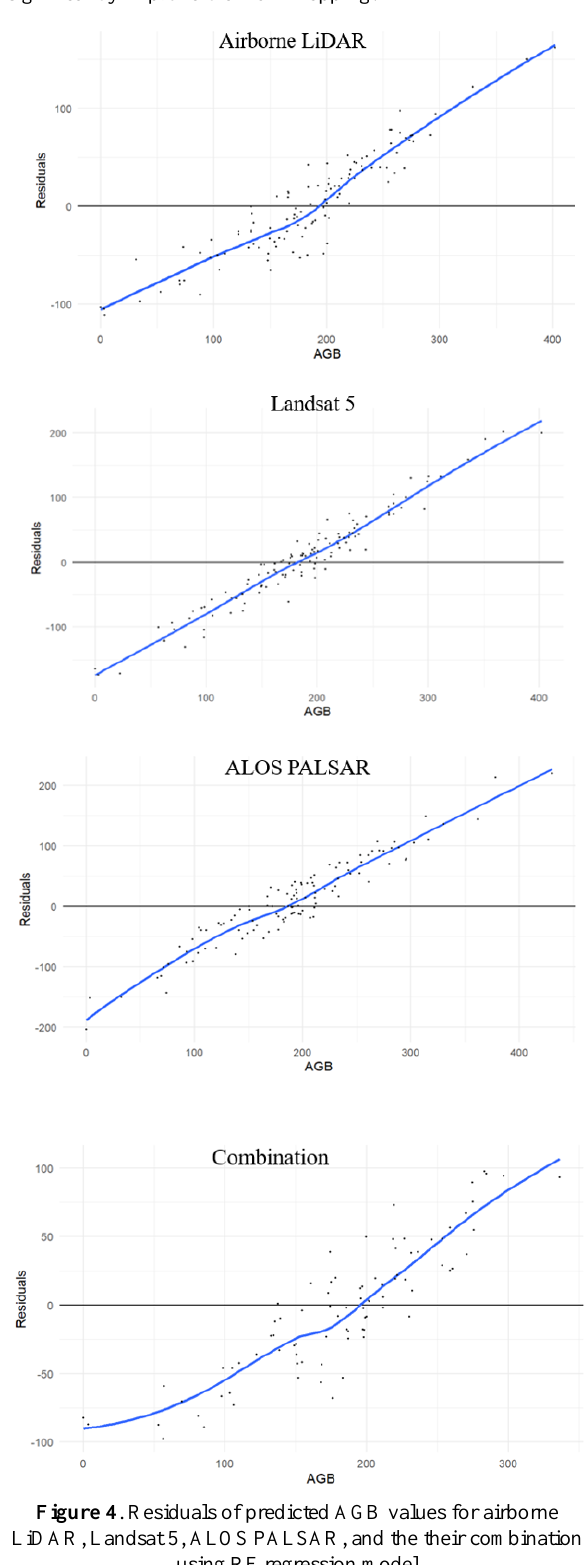
Figure 4 . Residuals of predicted AGB values for airborne LiDAR, Landsat 5, ALOS PALSAR, and the their combination using RF regression